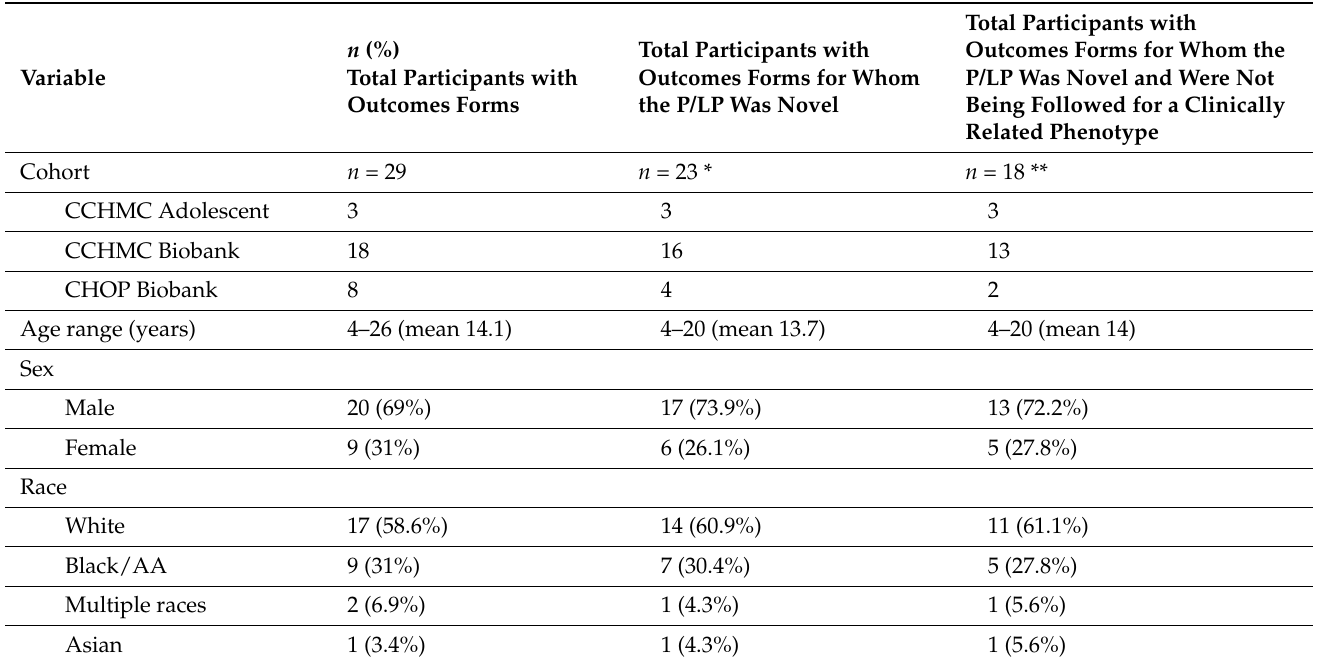
Table 2. Participant